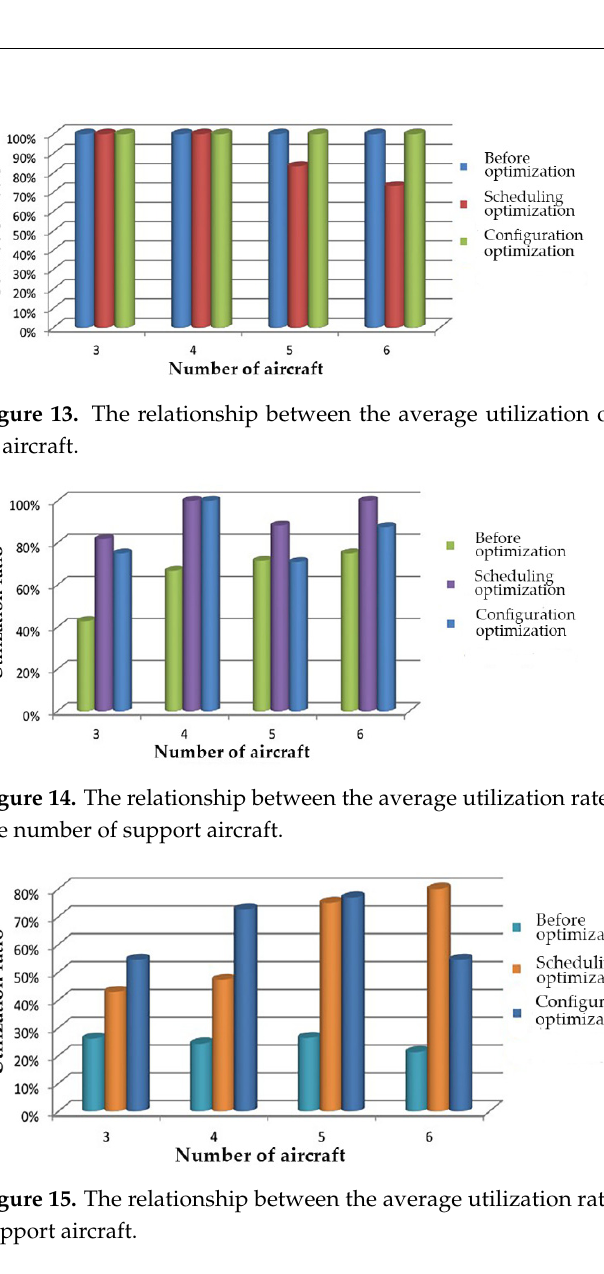
Figure 12. Multi-aircraft support three times.